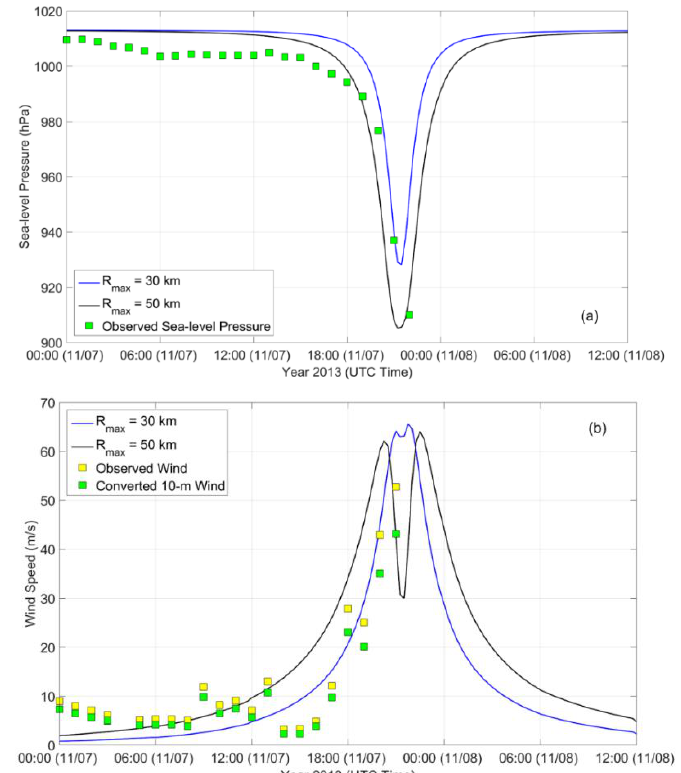
Figure 3. Comparisons of the Holland wind model (HWM) results between R max = 30 and 50 km with the observation data at the Guiuan weather station: ( a ) sea-level pressure; and ( b ) wind speed. The pressure distribution scaled by the 1999 Harper and Holland’s parameters is assumed. Note that the wind speed is measured on the level of 60 m [18], and the 10-m wind speed is converted using the power-law formula [67].